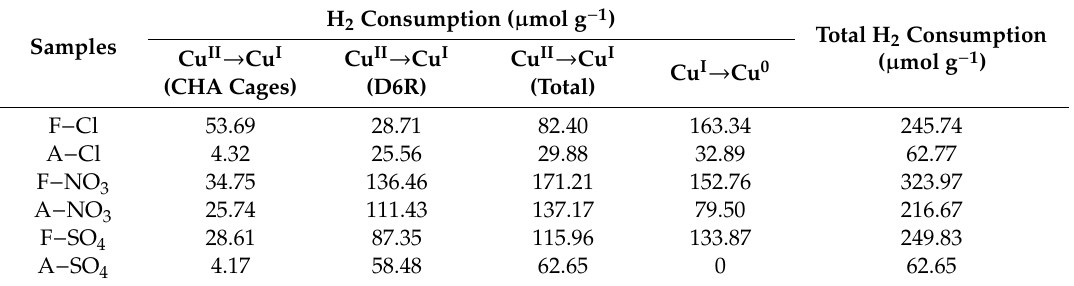
◦ C (Peak A) and 168